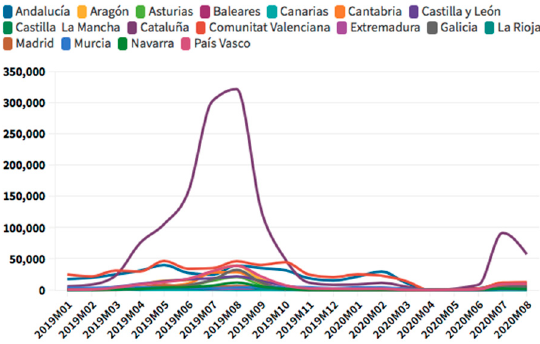
Figure 8. international tourism camping occupancy. Source: Own elaboration from INE data. Figure 8. International tourism camping occupancy. Source: Own elaboration from INE